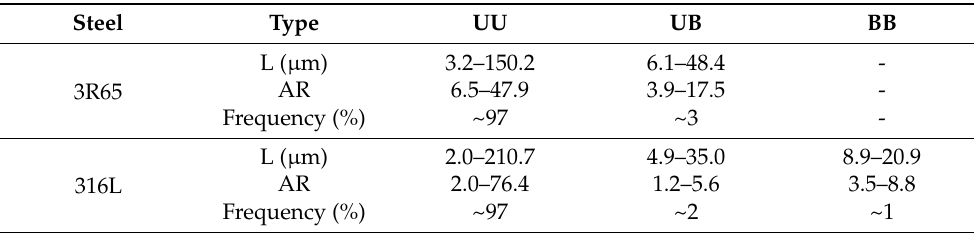
Table 6. The classification of elongated inclusions in the 3R65 and 316L steel grades when using Method 2.